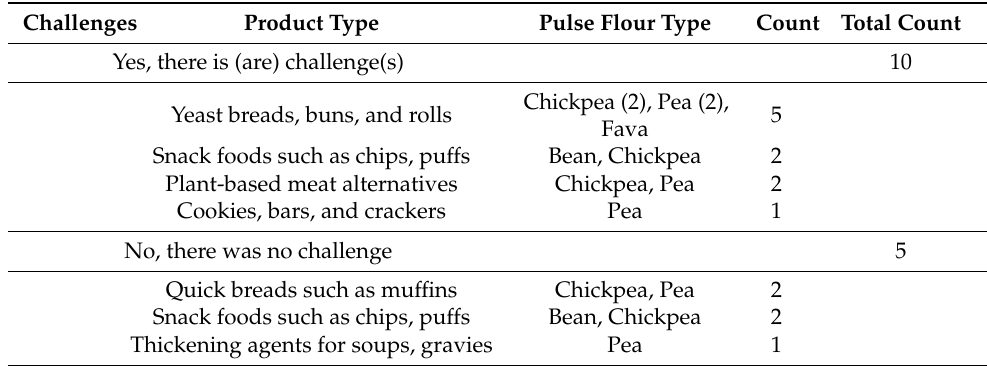
Table 8. Combination of product type and pulse flour type by the presence or absence of challenges in production. Counts more than one are shown in